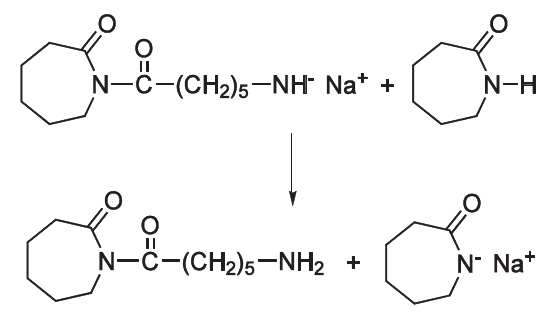
Figure 44. Regeneration of the lactam anion.